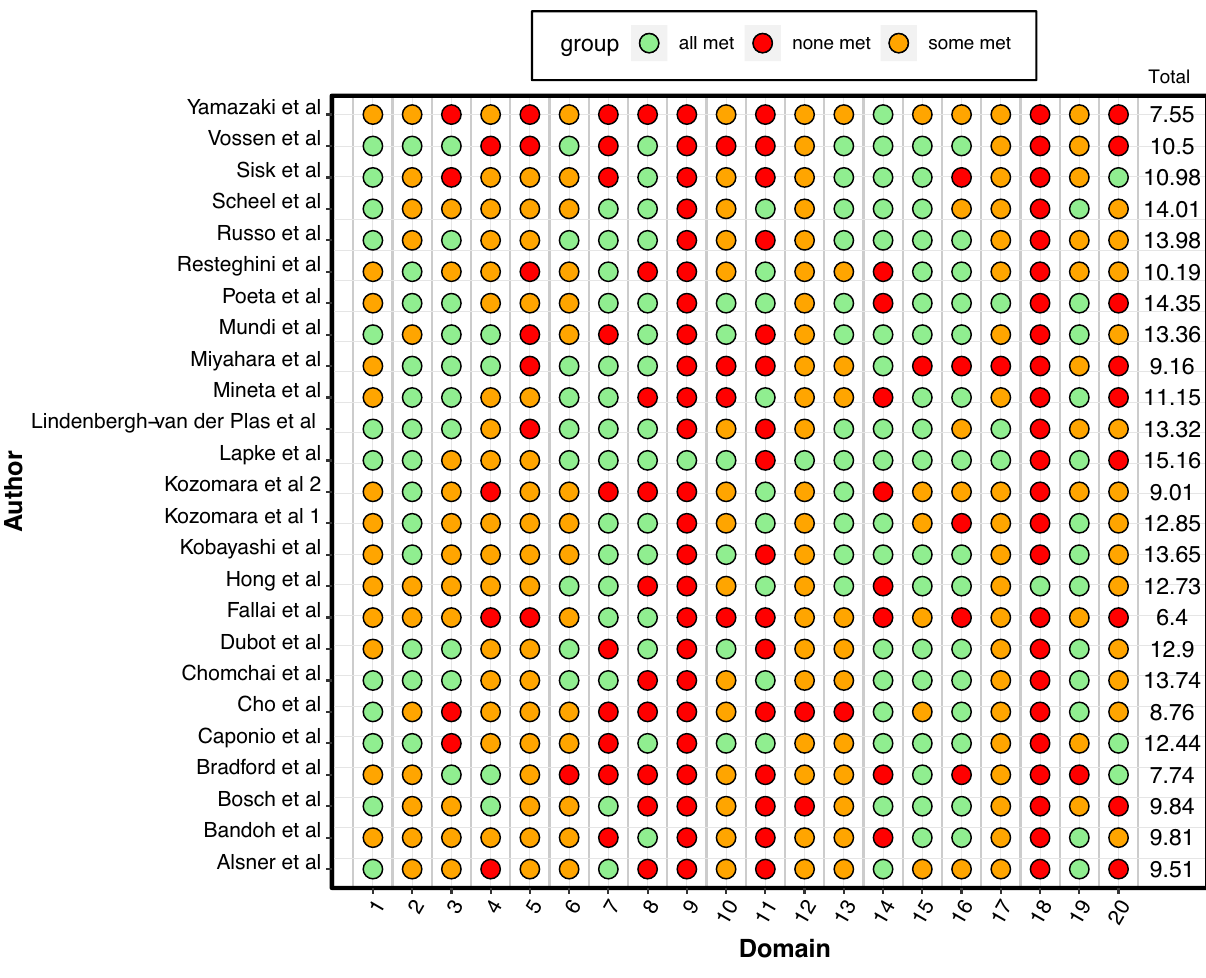
models were used to quantitatively assess overall survival, disease/progression-free survival, and disease spe- cific survival across reporting studies. Between studies, heterogeneity of outcomes was found to be significant for both disease-specific survival (tau 2 = 0.96; I 2 = 83.8% [95% CI 51.3; 94.6%], Q(2) = 12.36, p = 0.002) and dis-